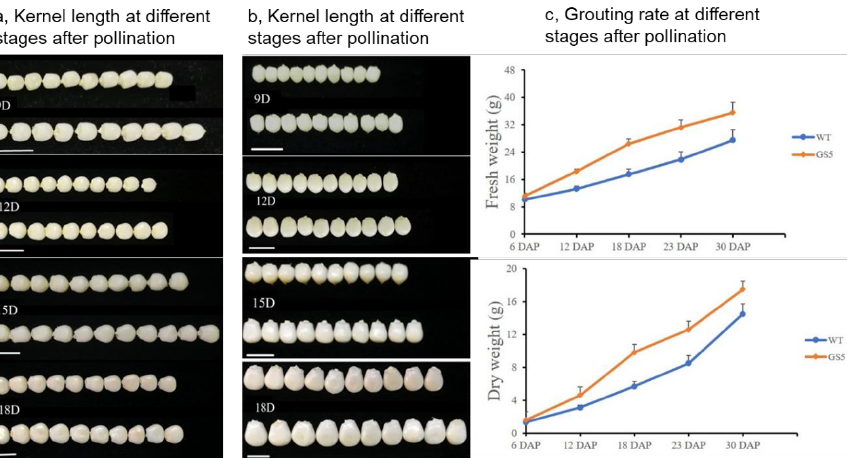
Figure 3. Comparison of kernel development and grouting rate dynamics between OE-34 and WT. ( a ) Dynamics of kernel length at different periods after pollination. Wild type (WT), top; OE-34, bottom; scale bar, 1 cm. ( b ) Dynamics of kernel width at different periods after pollination. WT, top; OE-25, bottom; scale bar, 1 cm. ( c ) Changes in fresh weight and dry weight of kernels on different days after pollination.